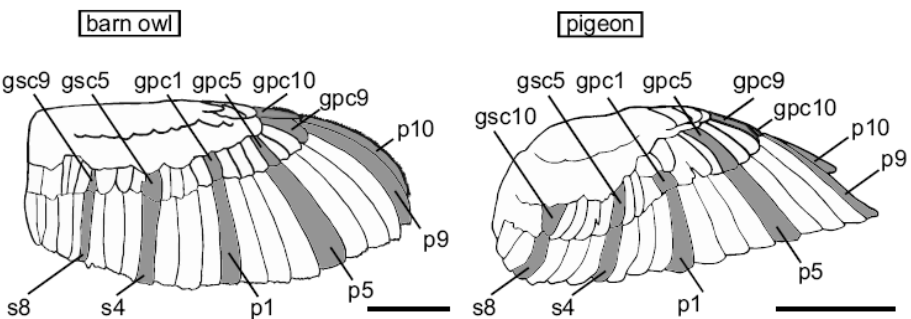
Figure 3. Feather position in the barn owl and the pigeon (scale bar represents 10 cm), as provided by Bachmann et al.